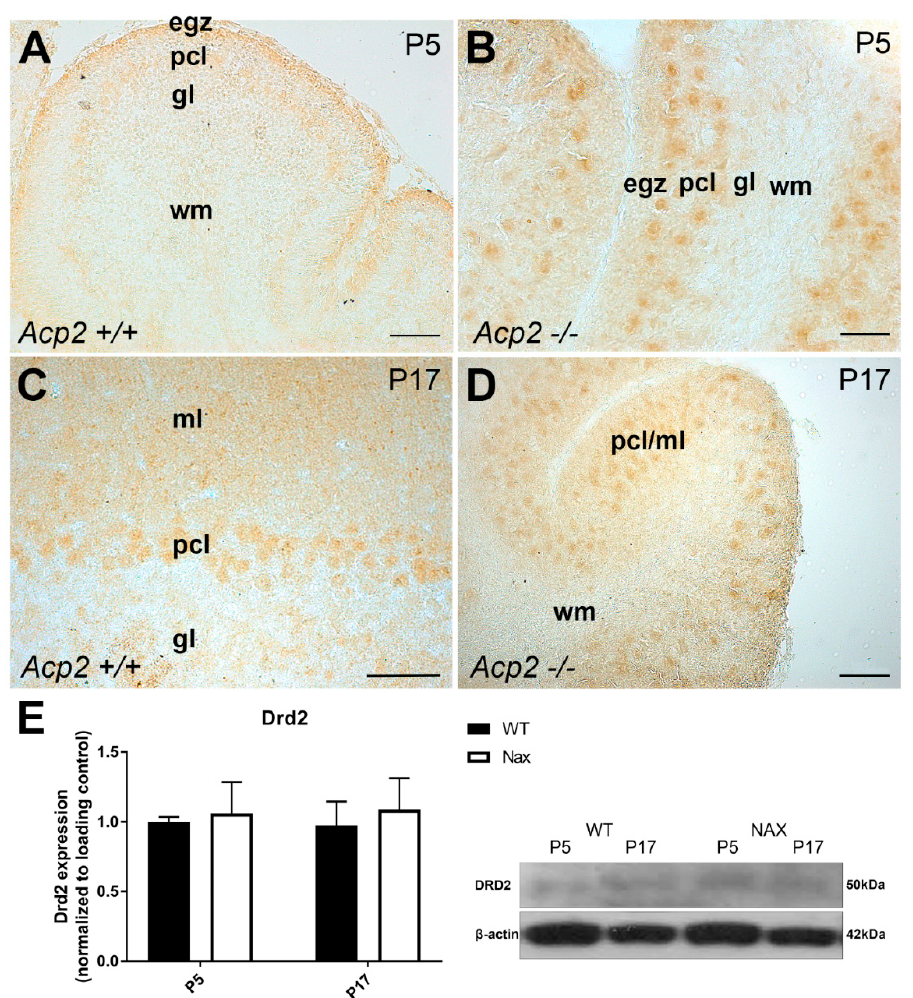
Figure 3. Frontal sections of wt and nax mouse cerebella: DRD2 expression at P5 and P17. Immunoperoxidase staining for DRD2 in wt ( A ) and nax ( B ) cerebella at P5 shows weak immunoreactivity in the Pcl of wt but relatively strong immunoreactivity in PC somata of the nax cerebellum. ( C , D ) Immunoperoxidase staining for DRD2 in wt ( C ) and nax ( D ) cerebella at P17 shows weak immunoreactivity in PCs, with no differences between the two groups. ( E ) Western blot analysis of whole cerebellar lysates revealed no significant differences in DRD2 protein expression between wt and nax cerebella at P5 and P17 (wt: n = 3 and nax : n = 3). The data in the bar graphs are presented as the means of three independent experiments ± SEM; statistical analysis was performed using two– way ANOVA. P; postnatal. Scale bars: 100 μ m in A, C, and D and 50 μ m in B.